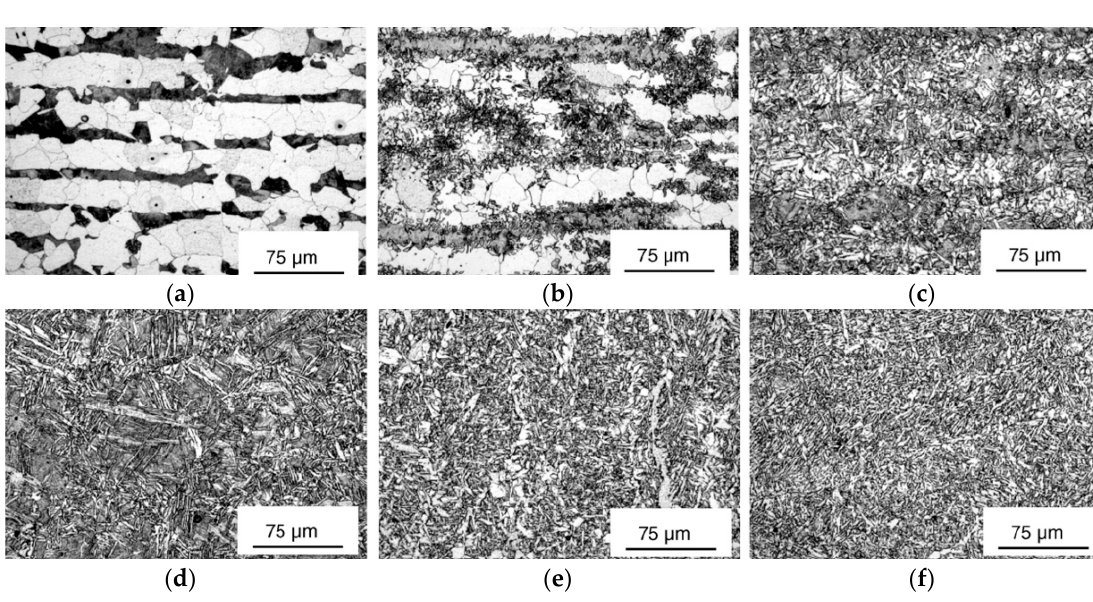
Figure 15. Macrograph of double-sided hybrid joint ( a ), microstructure of base material ( b ), laser zone ( c ) and arc zone ( d ), where F corresponds to polygonal ferrites, SGC to small granular carbides, CGB to columnar grain boundary and M to martensite (reproduced from [82] with permission, Elsevier, 2013).